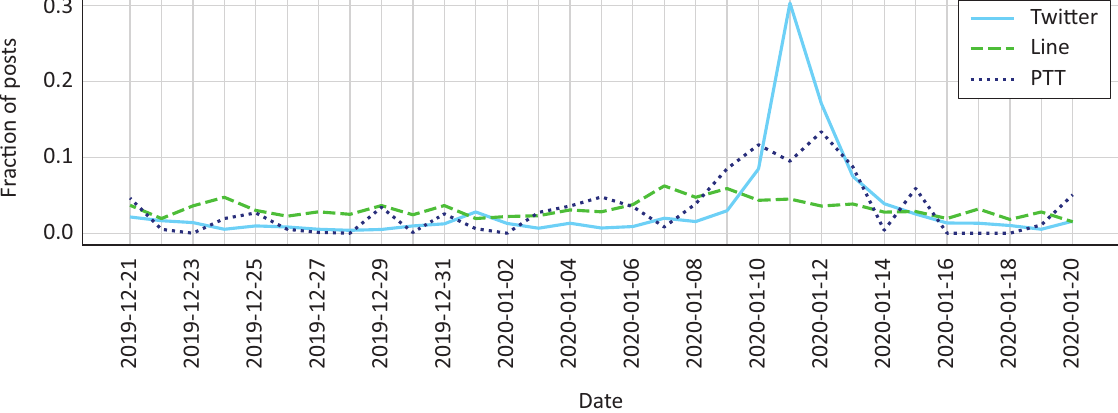
Figure 1. Fraction of posts per day on each platform during the collection